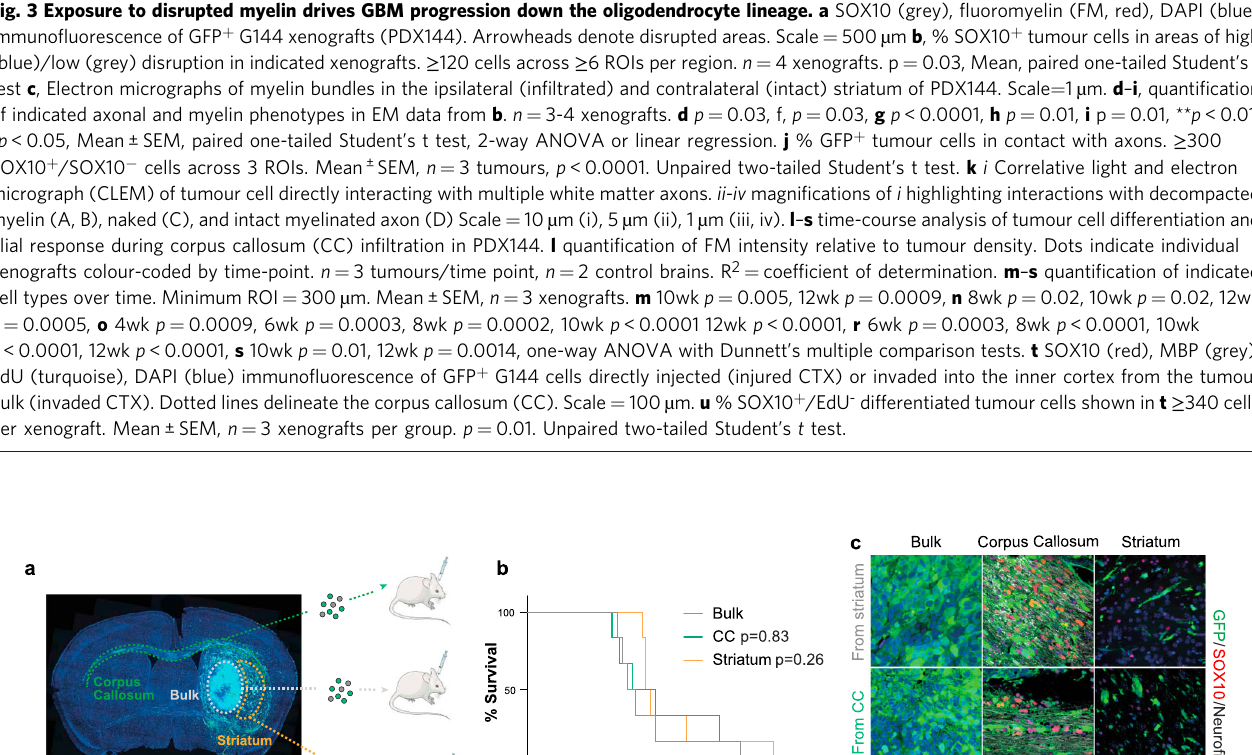
Fig. 3 Exposure to disrupted myelin drives GBM progression down the oligodendrocyte lineage. a SOX10 (grey), fl uoromyelin (FM, red), DAPI (blue) immuno fl uorescence of GFP + G144 xenografts (PDX144). Arrowheads denote disrupted areas. Scale = 500 µ m b , % SOX10 + tumour cells in areas of high (blue)/low (grey) disruption in indicated xenografts. ≥ 120 cells across ≥ 6 ROIs per region. n = 4 xenografts. p = 0.03, Mean, paired one-tailed Student ’ s t test c , Electron micrographs of myelin bundles in the ipsilateral (in fi ltrated) and contralateral (intact) striatum of PDX144. Scale = 1 µ m. d – i , quanti fi cation of indicated axonal and myelin phenotypes in EM data from b . n = 3-4 xenografts. d p = 0.03, f, p = 0.03, g p < 0.0001, h p = 0.01, i p = 0.01, ** p < 0.01, * p < 0.05, Mean± SEM, paired one-tailed Student ’ s t test, 2-way ANOVA or linear regression. j % GFP + tumour cells in contact with axons. ≥ 300 SOX10 + /SOX10 − cells across 3 ROIs. Mean ± SEM, n = 3 tumours, p < 0.0001. Unpaired two-tailed Student ’ s t test. k i Correlative light and electron micrograph (CLEM) of tumour cell directly interacting with multiple white matter axons. ii-iv magni fi cations of i highlighting interactions with decompacted myelin (A, B), naked (C), and intact myelinated axon (D) Scale = 10 µ m (i), 5 µ m (ii), 1 µ m (iii, iv). l – s time-course analysis of tumour cell differentiation and